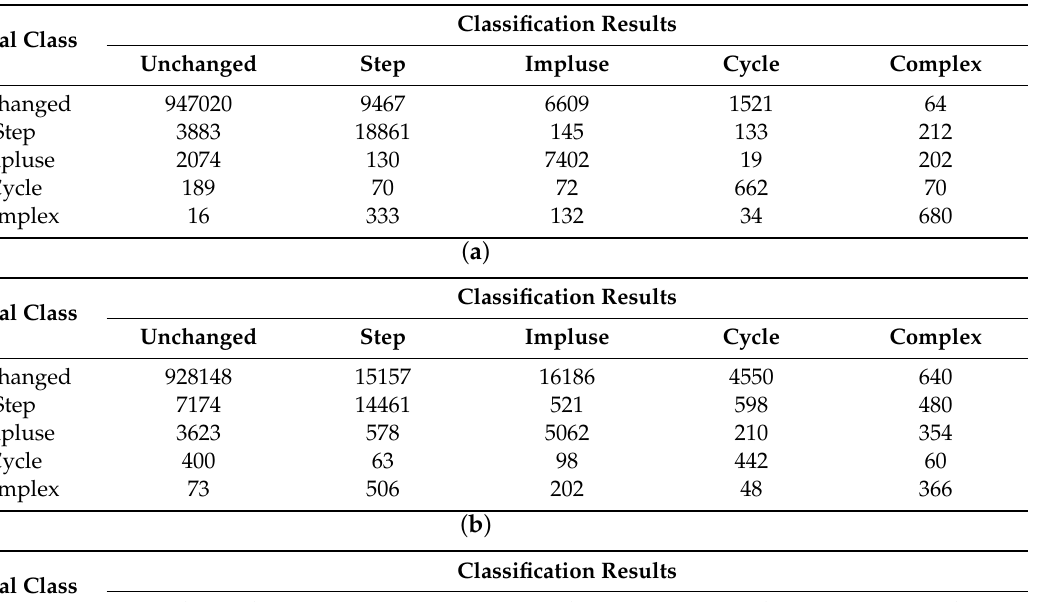
Table 5. The multi-class confusion matrix of di ff erent classification results using realistic